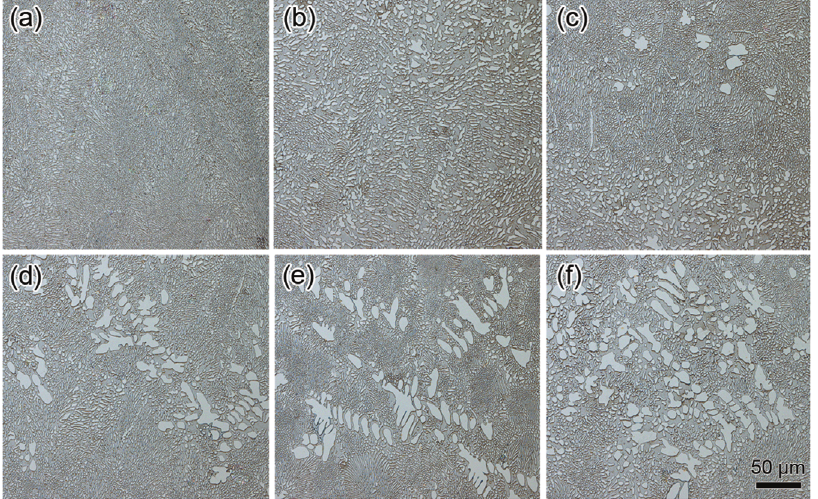
Figure 2: Optical images in different positions of the as-cast Fe-10%Nb alloy: (a) the bottom part of the ingot; (b) and (c) the lower part of the ingot; (d) and (e) the middle part of the ingot; (f) the top part of the ingot.